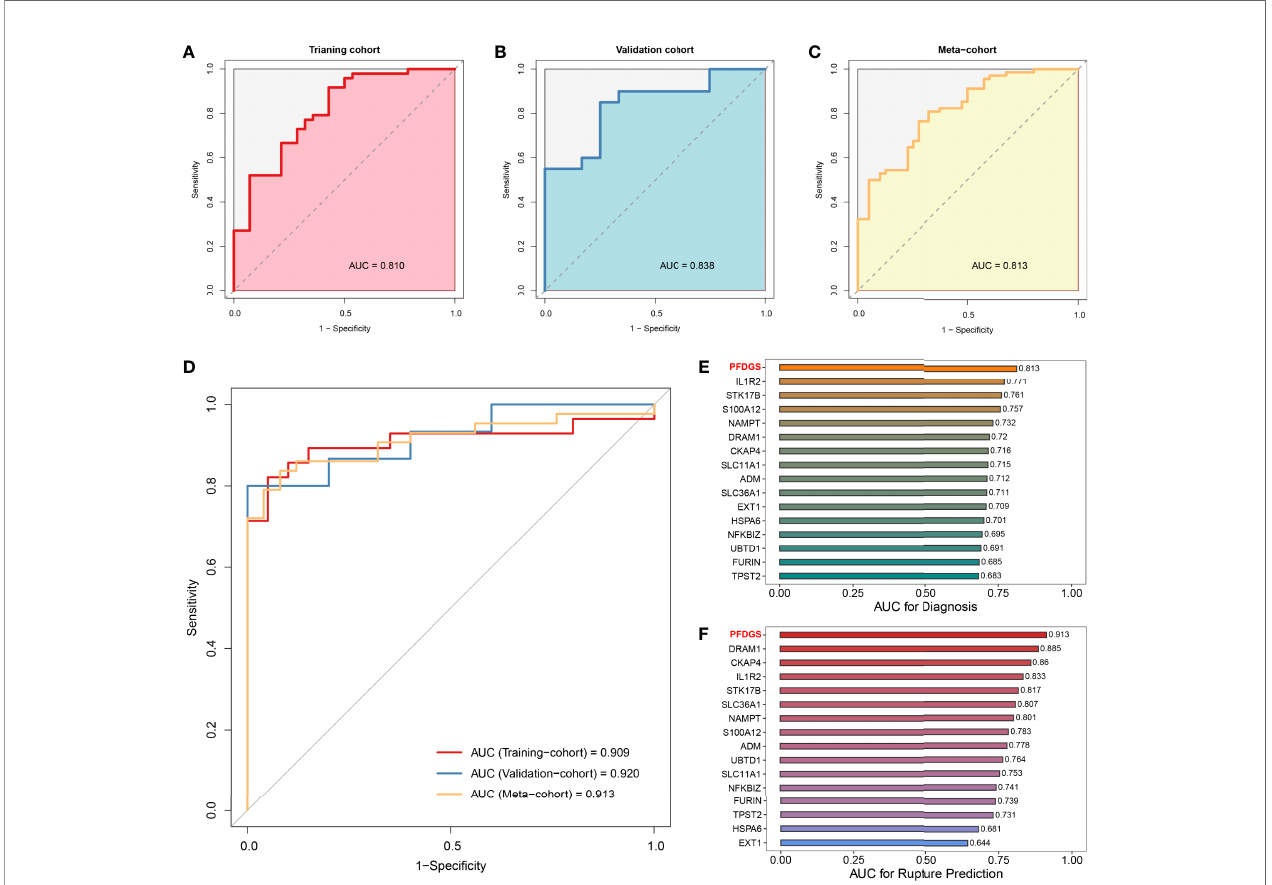
FIGURE 7 | Diagnostic and predictive value of PFDGS. (A-C). ROC analysis of the PFDGS for IA diagnosis in the training cohort (A) , validation cohort (B) , and meta-cohort (C) . (D) ROC analysis of the PFDGS for predicting IA rupture in the training cohort, validation, and meta cohorts. (E, F). AUC values of PFDGS and 15 initial candidate marker genes for IA diagnosis (E) and rupture prediction (F) in the